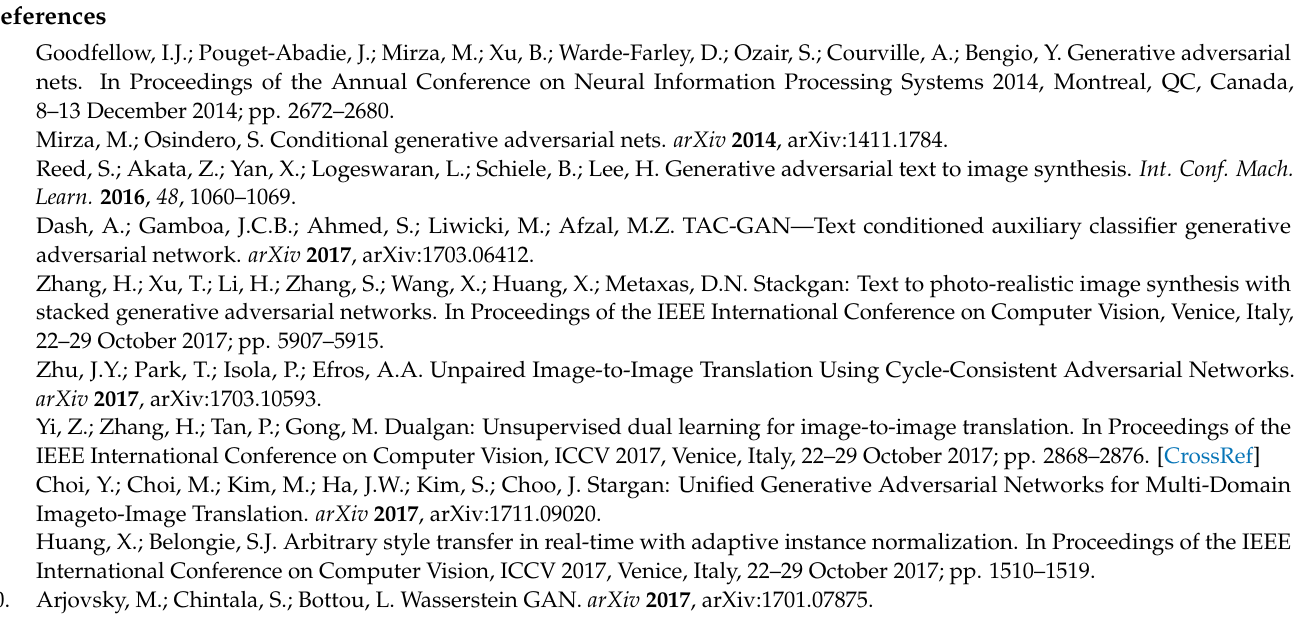
Figure A3. Reference guided synthesis images (The first column is the original image, the first row is the reference